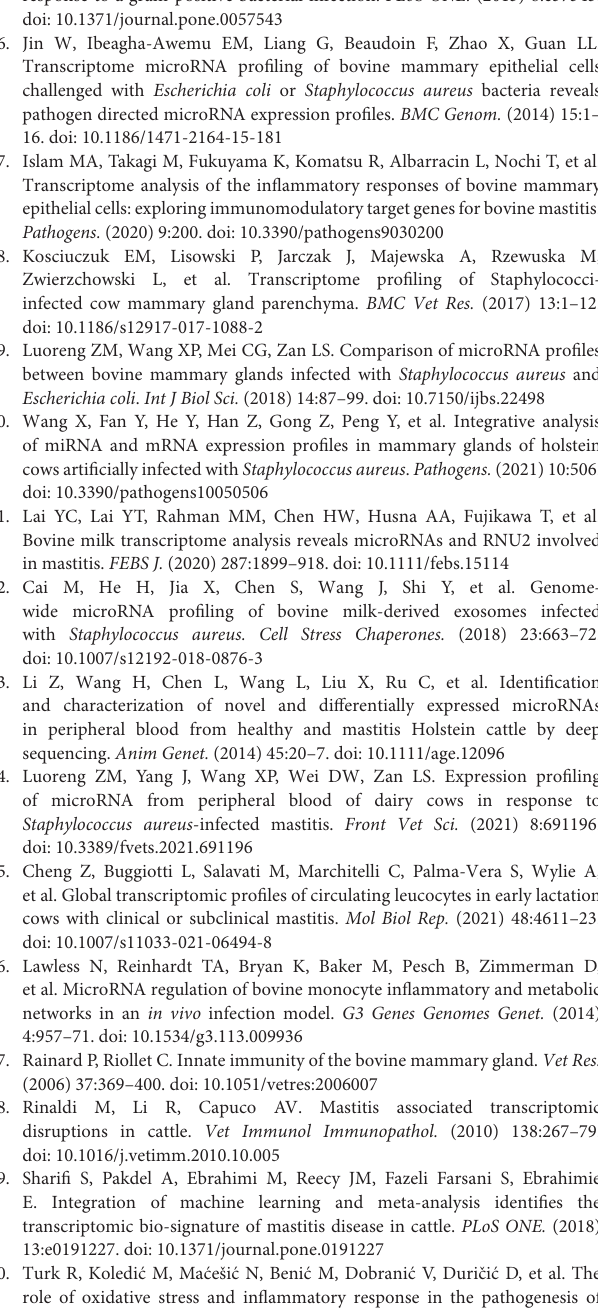
Supplementary Table 2 | The differentially expressed genes (DEGs) in LPS-induced 4, 8, and 12h bMECs. (A) DEGs in LPS-induced 4h bMECs. (B) DEGs in LPS-induced 8h bMECs. (C) DEGs in LPS-induced 12h bMECs. Supplementary Table 3 | The expression level of miRNA in LPS-induced bMEC at 0, 4, 8, and 12h. Supplementary Table 4 | The differentially expressed miRNAs (DEMs) in LPS-induced 4, 8, and 12h bMECs. (A) DEMs in LPS-induced 4h bMECs. (B) DEMs in LPS-induced 8h bMECs. (C) DEMs in LPS-induced 12h